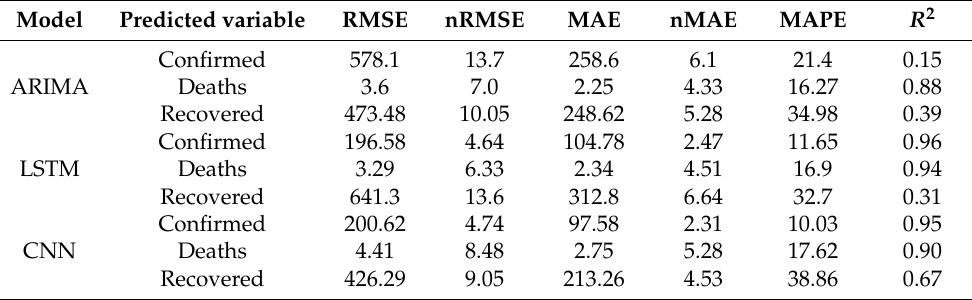
Table 4. Performance evaluation of the three predictive